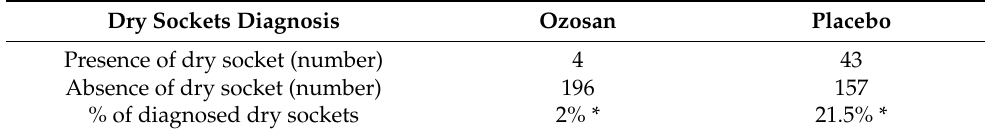
form of sunflower oil-based gel (Ozosan) or placebo gel. The incidence percentage of dry sockets was calculated with respect to 200 inferior third molars extracted per treatment. The * symbol denotes a statistically significant difference ( p < 0.05) between the two treatments, as calculated using the chi-square test.